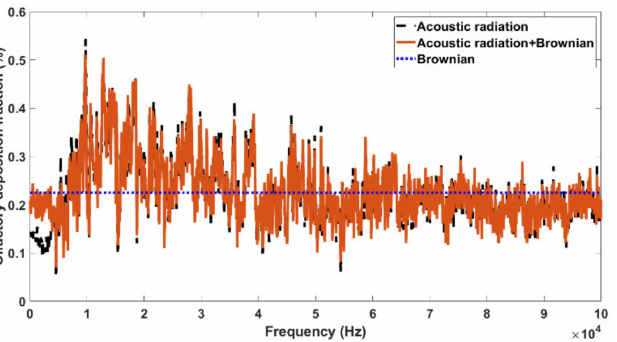
Figure 6. Effect of Brownian motion on olfactory deposition in the baseline case (Case